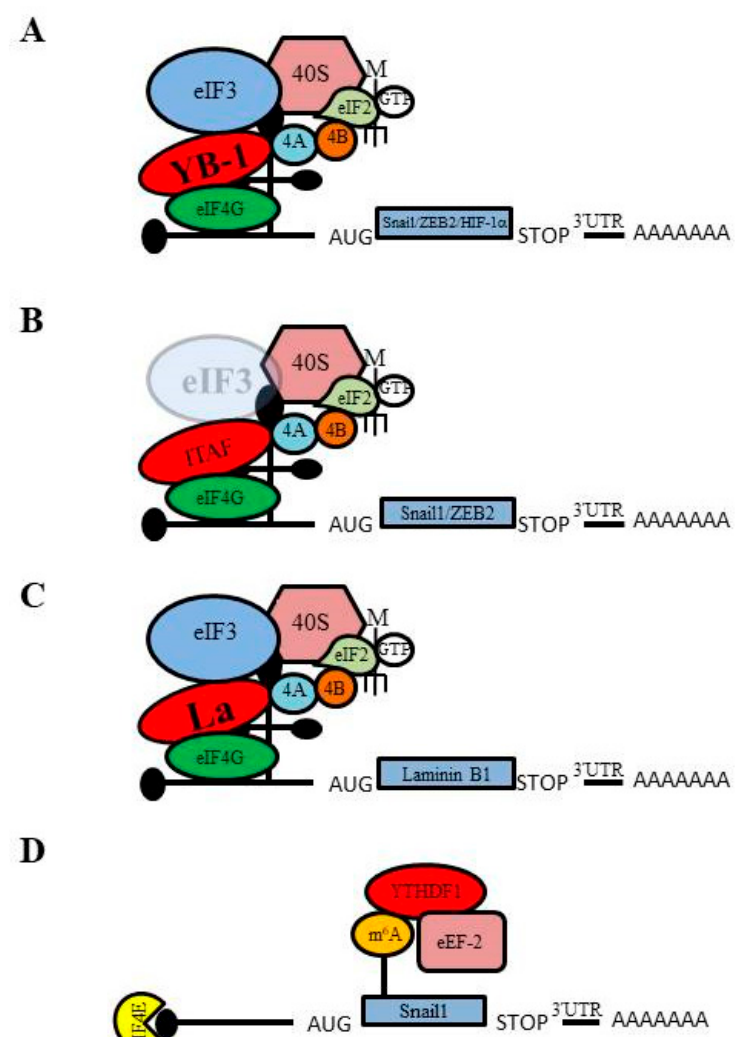
Figure 3. Alternative translation mechanisms are involved in the synthesis of proteins with roles in epithelial-to-mesenchymal transition (EMT). ( A ) The YB-1 protein recruits the translation initiation machinery to mRNAs that encode Snail1, ZEB2, and HIF-1 α to support their synthesis, leading to EMT. ( B ) Reduced expression of the initiation factor eIF3e facilitates the translation of the Snail1 and ZEB2 proteins to mediate EMT. ( C ) The ITAF La mediates the translation of Laminin B1 to drive cells toward EMT. ( D ) m 6 A modifications within the Snail1 open reading frame permit enhanced recruitment of the elongation factor eEF-2 via YTHDF1 to increase Snail 1 translation and facilitate EMT.